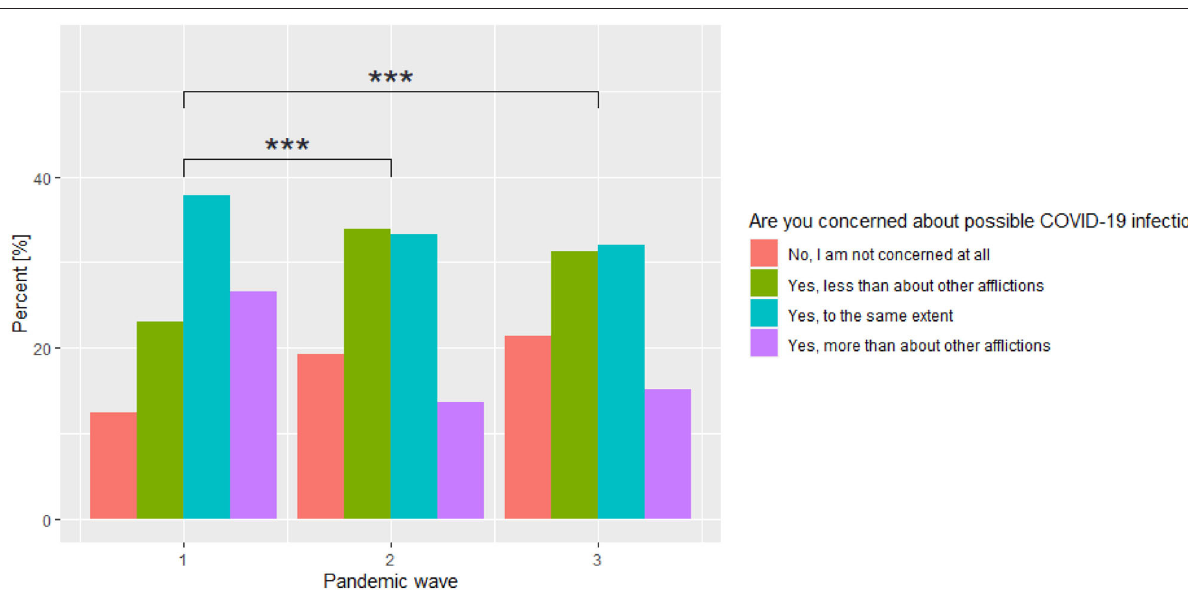
with other people, increased sensitivity to their own mental, and physical health or hygiene